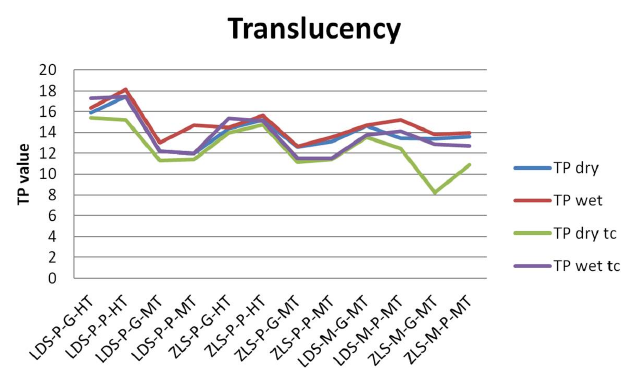
Figure 3. Results of the translucency measurements before and after thermocycling.